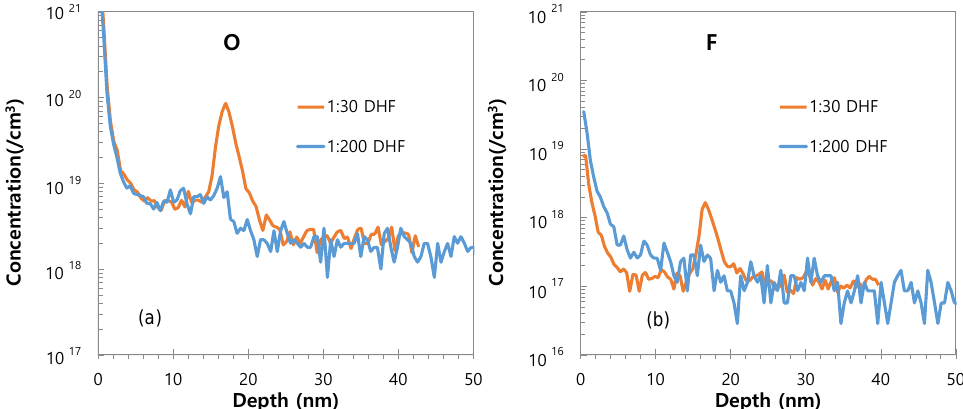
Figure 2. The secondary ion mass spectroscopy (SIMS) profiles of the SiGe epitaxial films obtained after pre-cleaning with 1:30 DHF and 1:200 DHF, indicating the concentrations of ( a ) O and ( b ) F.